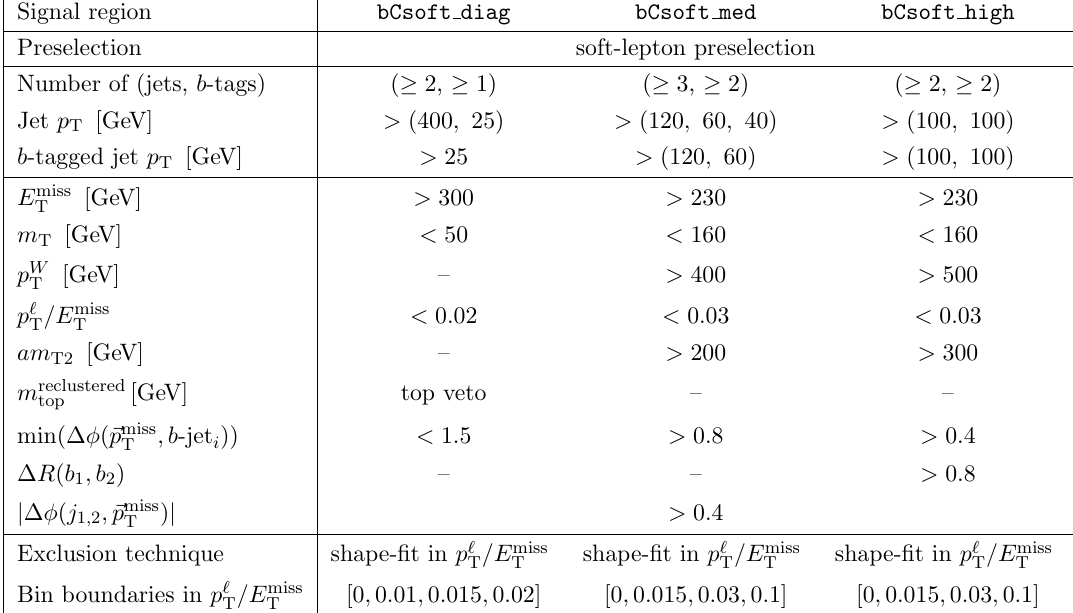
Table 10 . Overview of the event selections for the bCsoft diag , bCsoft med , and bCsoft high SRs. List values are provided in between parentheses and square brackets denote intervals. The veto on the reclustered hadronic top-quark candidate is satis(cid:12)ed for events where no reclustered jet candidate is found, or where the mass of the hadronic top-quark candidate ( m reclustered